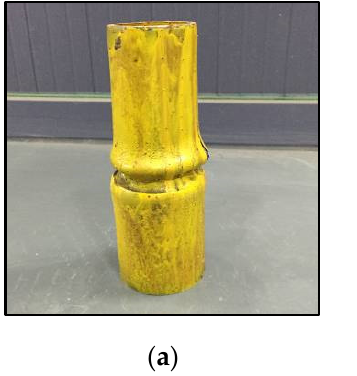
Figure 18. Shear failure modes of sleeves: ( a ) SJ-1; ( b ) SJ-2.